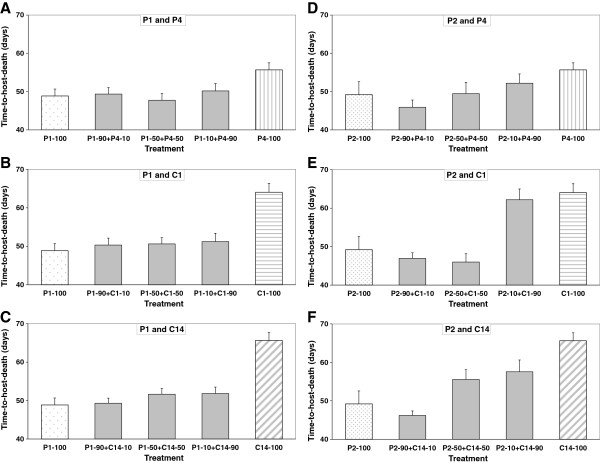
Time-to-host-death (virulence) in single and mixed infections. Time-to-host-death (virulence) in single and mixed infections by the parasite isolates/clones (A) P1 and P4 (B) P1 and C1 (C) P1 and C14 (D) P2 and P4 (E) P2 and C1, and (F) P2 and C14. Error bars are standard errors.